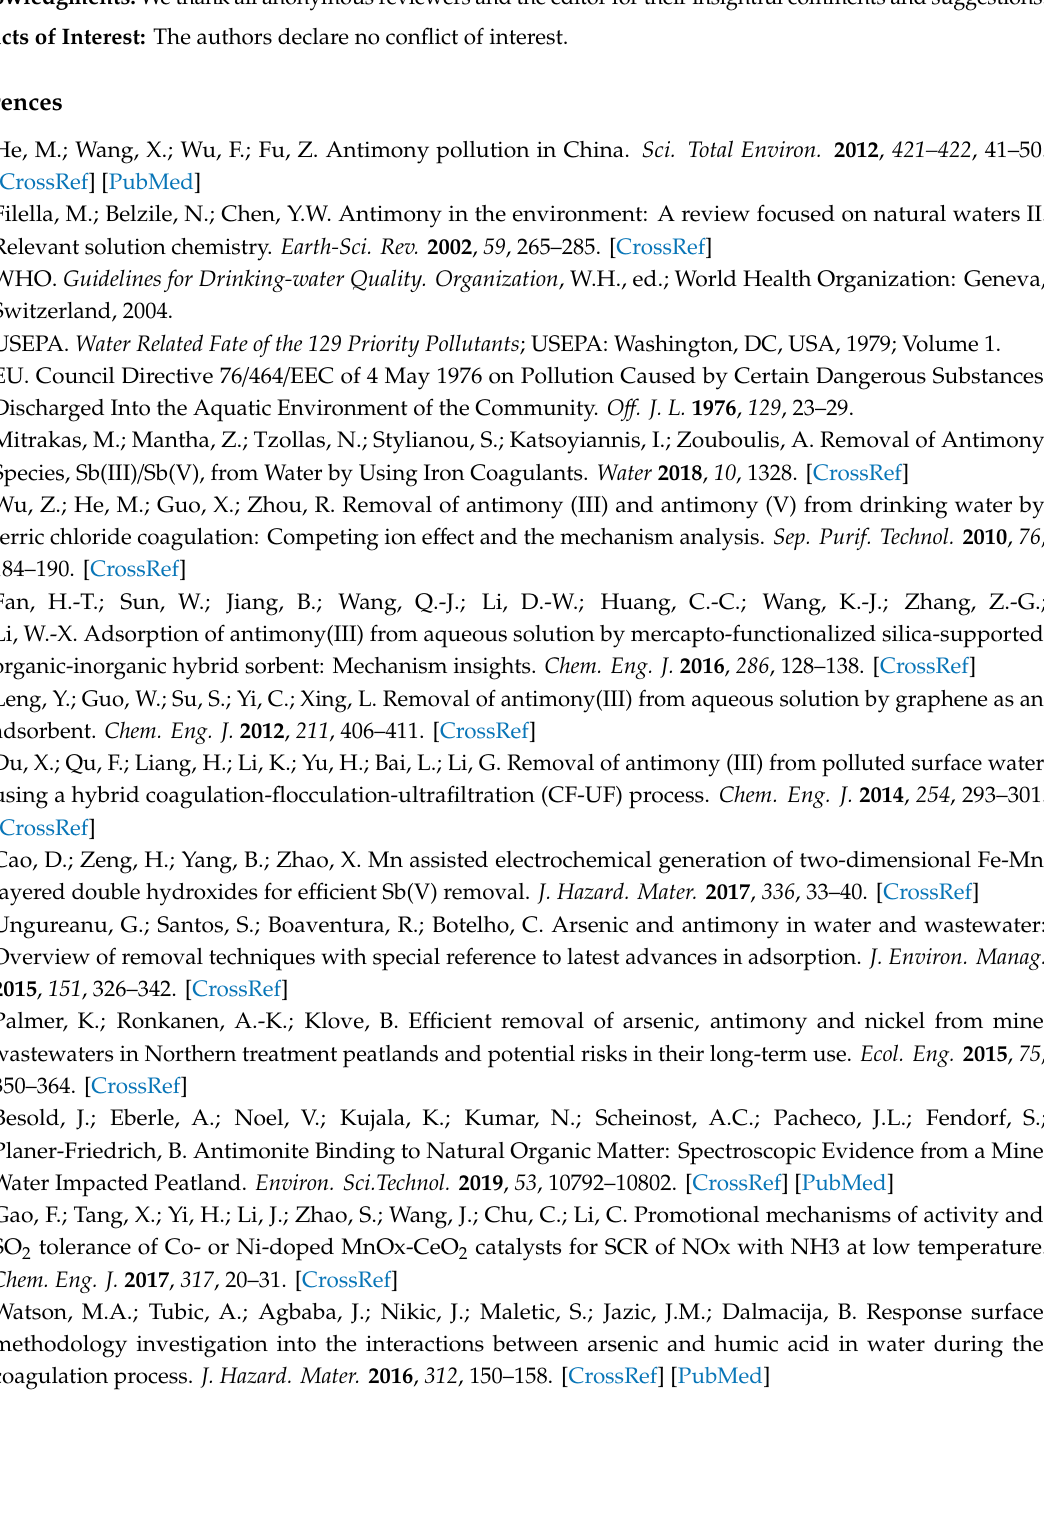
Figure S1: Removal of Sb from Taihu lake water by coagulation using PFS (initial concentration of Sb(III): 104 µ g · L − 1 ; Sb(V): 116 µ g · L − 1